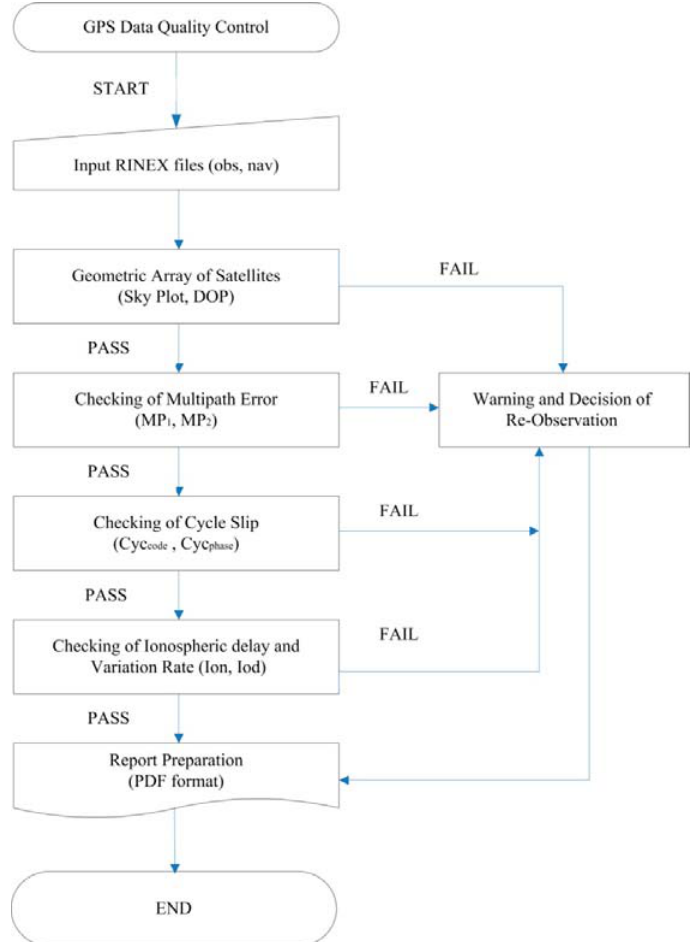
Figure 1. General flow of the GPSQC